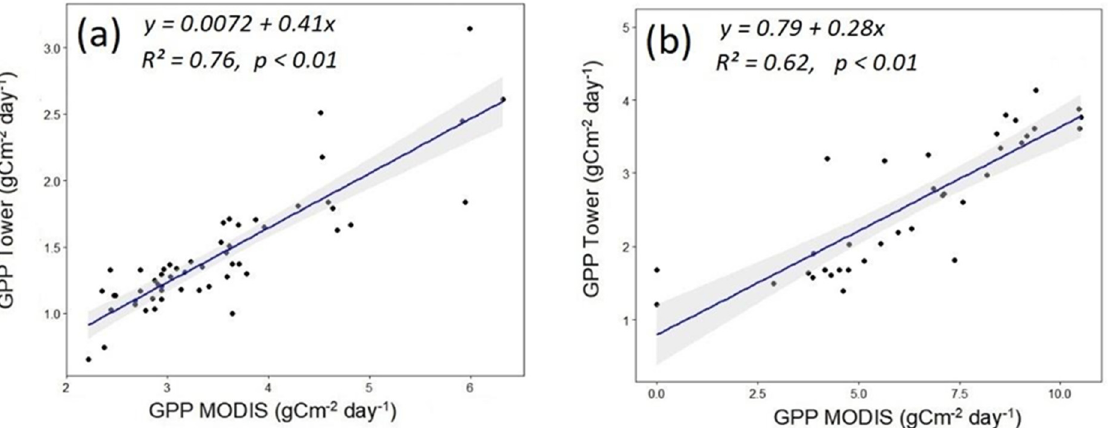
Figure 6. Relationship between measured gross primary production (GPP Tower) and MODIS gross primary production (GPP MODIS) in the dry season ( a ) and wet season ( b ) for the ESEC-Seridó site. Gray bands represent the 95% confidence interval for the fitted linear model.